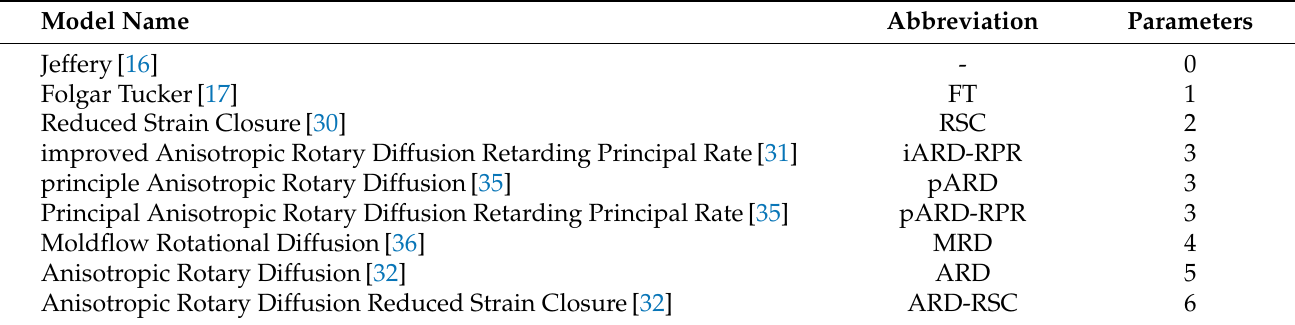
Table 1. Commonly used orientation prediction models sorted by the number of model